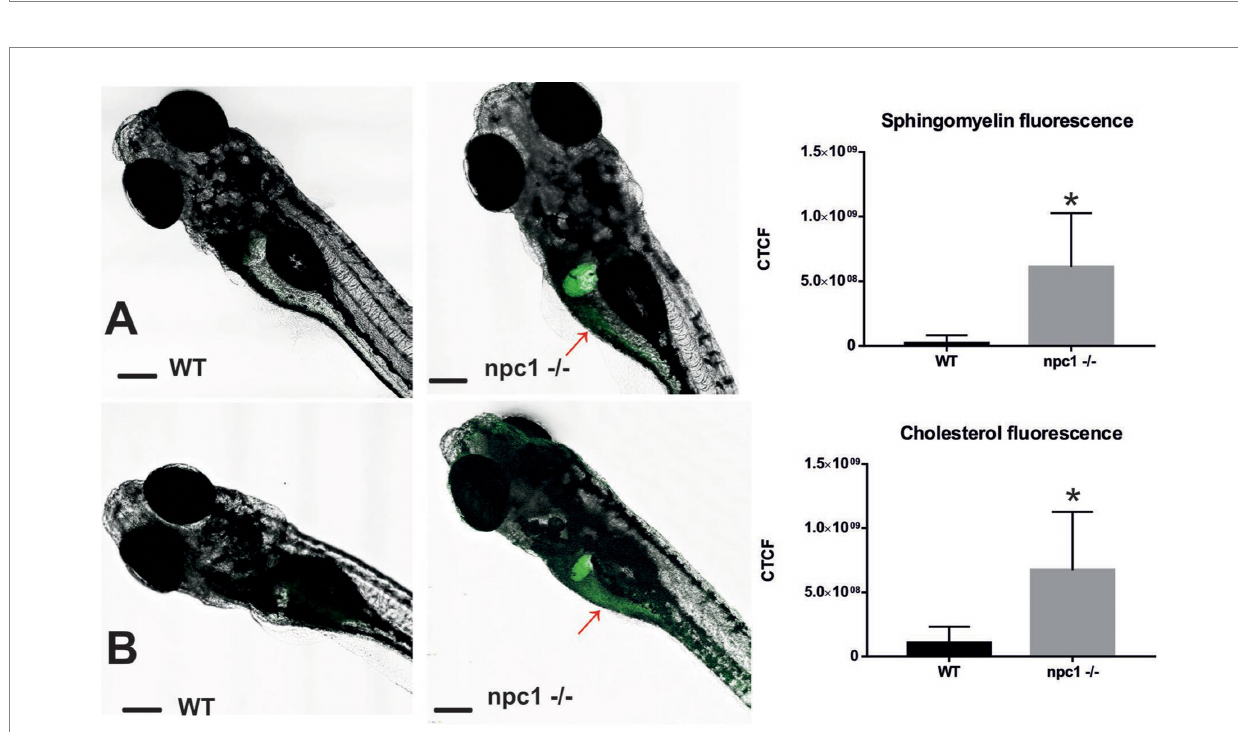
FIGURE 7 Both sphingomyelin (A) and cholesterol (B) produce aggregations mainly in the liver of the npc1 − / − but also in the intestine (red arrows) at 2 wpf. CTCF test showed increased fluorescence in npc1 − / − animals at 3 wpf for both sphingomyelin (A) and cholesterol (B) stainings (value of p < 0.001). Scale bars: 100 μ m. Statistically significant data in the graphs is indicated with a